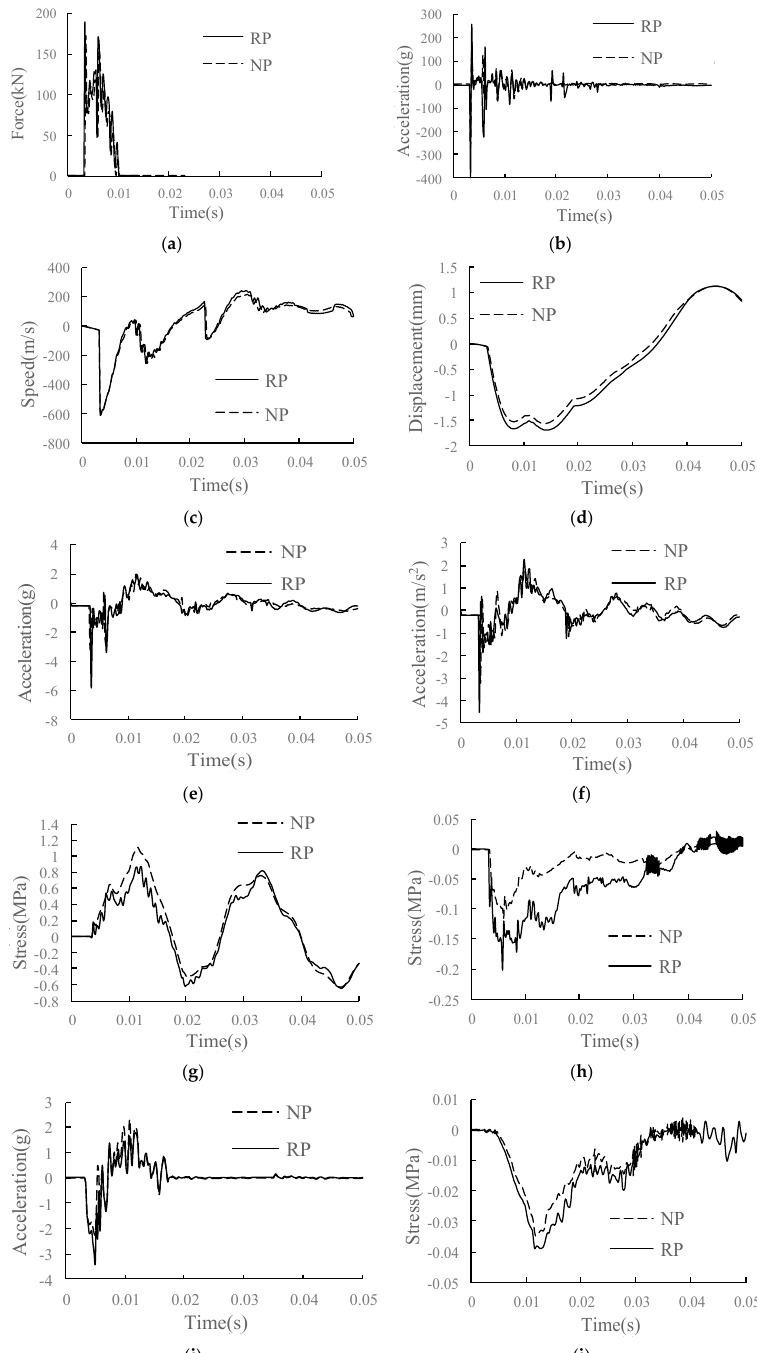
Figure 21. Dynamic response diagram of each structural layer in the condition of RP: ( a ) wheel–rail vertical force; ( b ) rail acceleration; ( c ) rail vertical speed; ( d ) rail vertical displacement; ( e ) track slab acceleration; ( f ) acceleration of SCC layer; ( g ) longitudinal stress of SCC layer; ( h ) vertical stress of SCC layer; ( i ) base acceleration; ( j ) vertical stress of substructure.